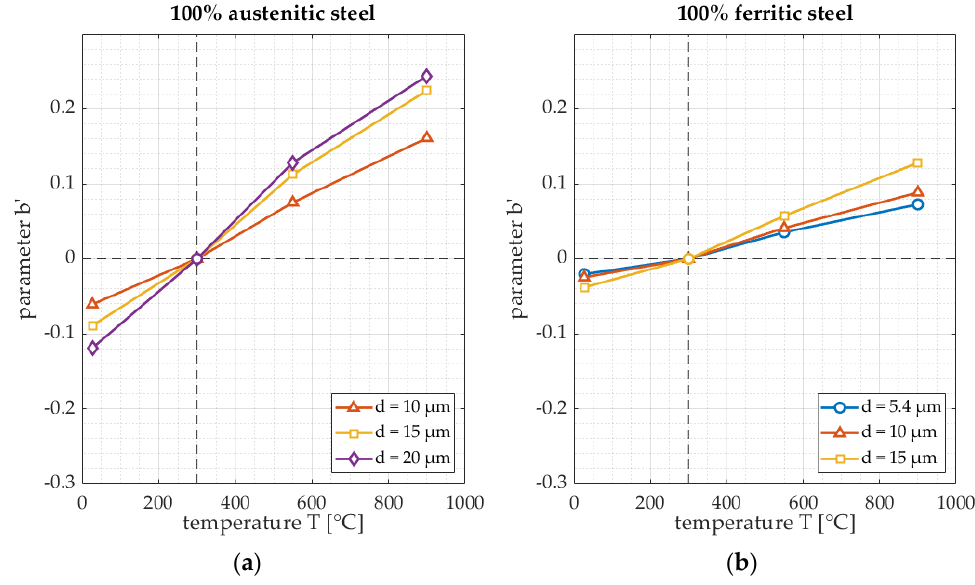
Figure 15. The relation between the temperature 𝑇 , and parameter 𝑏′ for two material types and three diameters: ( a ) shows 100% austenitic steel; and ( b ) 100% ferritic steel.